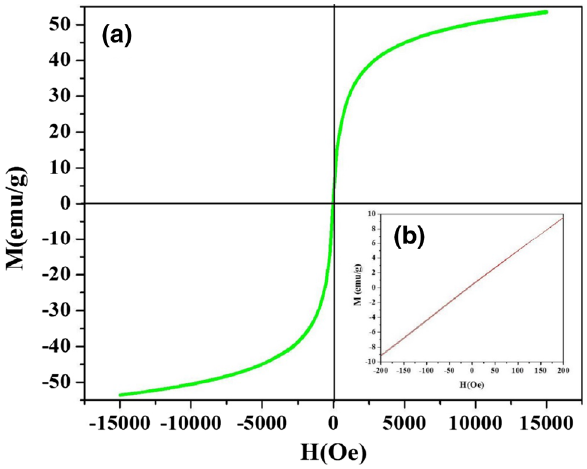
Fig. 5 The representative TEM images of L-Asp capped Fe (SAED) of L-Asp capped Fe